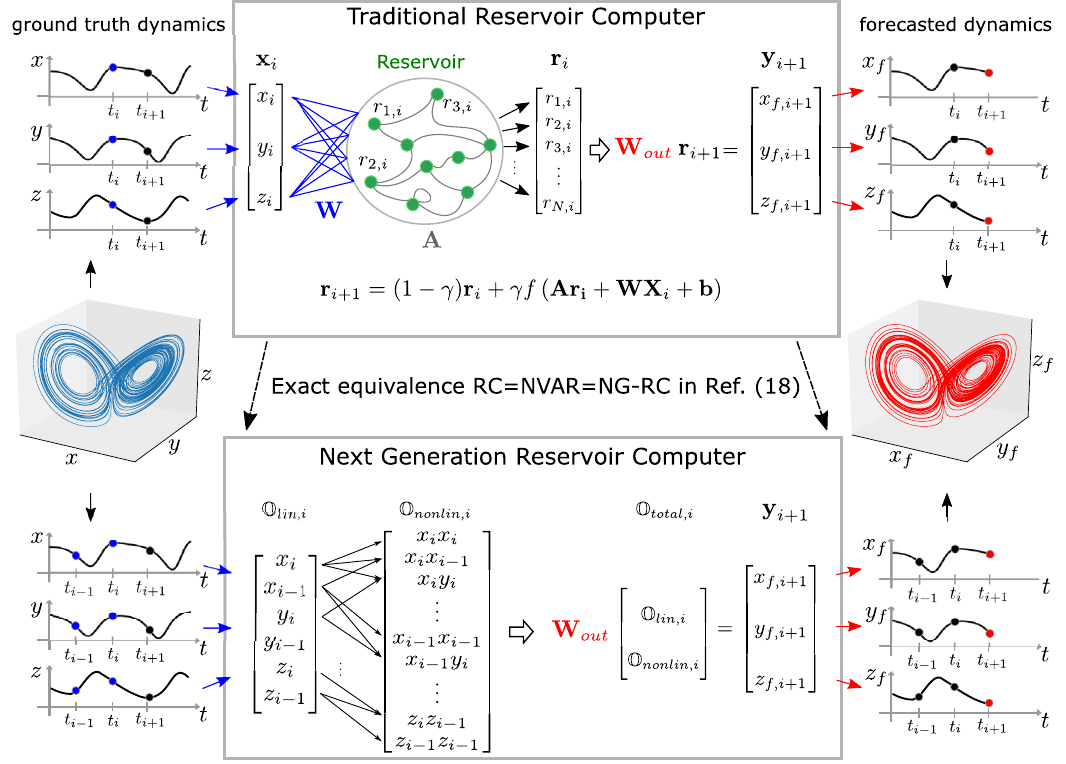
Fig. 1 A traditional RC is implicit in an NG-RC. (top) A traditional RC processes time-series data associated with a strange attractor (blue, middle left) using an arti fi cial recurrent neural network. The forecasted strange attractor (red, middle right) is a linear weight of the reservoir states. (bottom) The NG- RC performs a forecast using a linear weight of time-delay states (two times shown here) of the time series data and nonlinear functionals of this data (quadratic functional shown